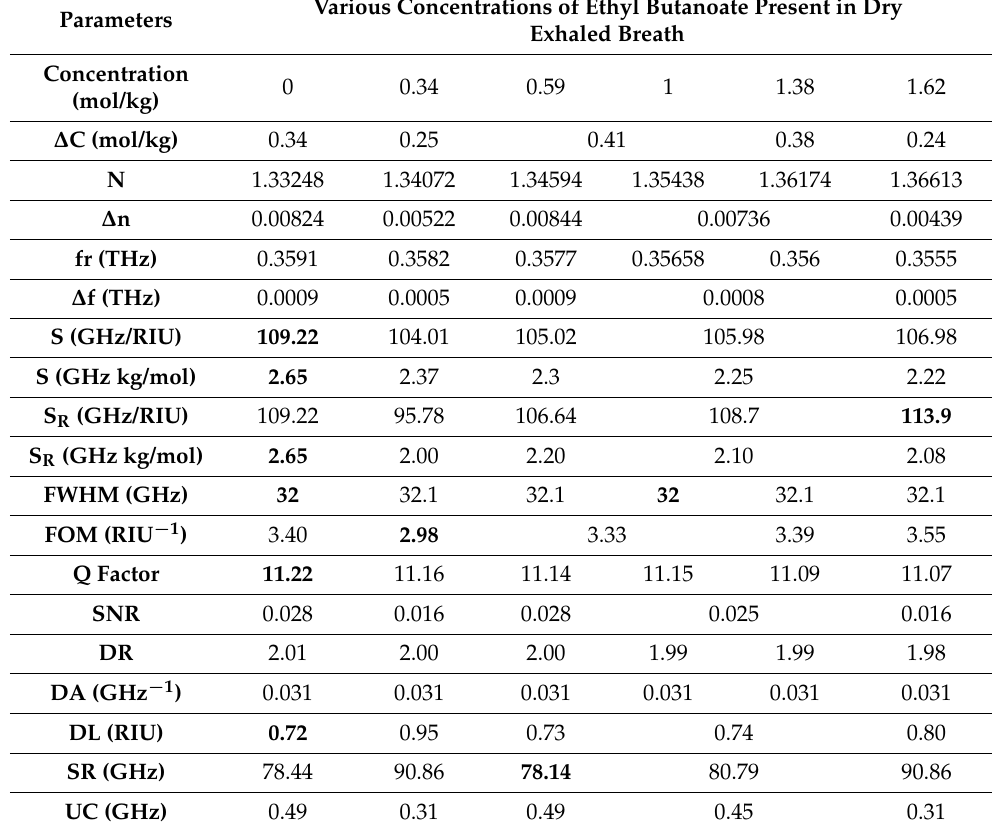
Table 2. Graphene-metasurface-inspired sensor’s performance for Mg 2+ Detection.